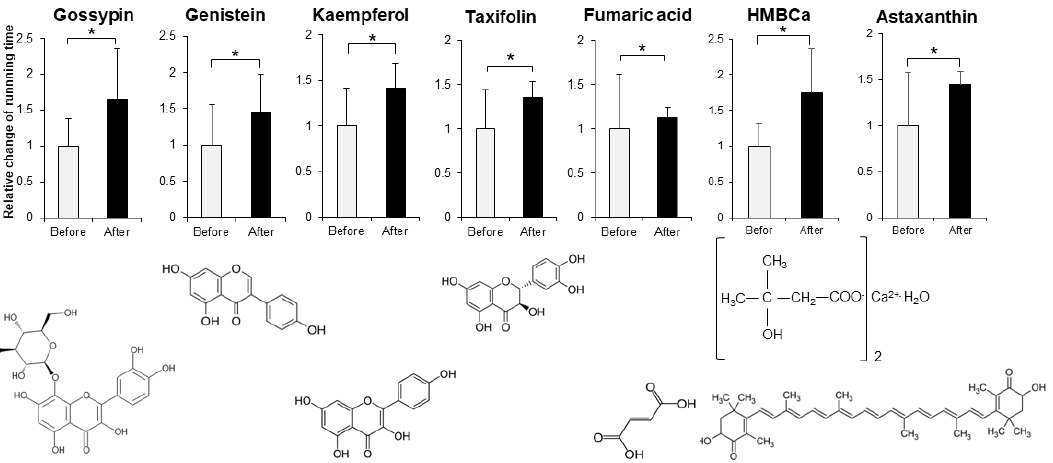
Figure 2. Functional factors that enhance the running activity of muscle- Sod2 -/- mice. Positive effects of functional factors on the treadmill task performance of muscle- Sod2 -/- mice (top) and structural formulas of each compound (bottom). * p < 0.05. Data are shown as the mean ± SD.